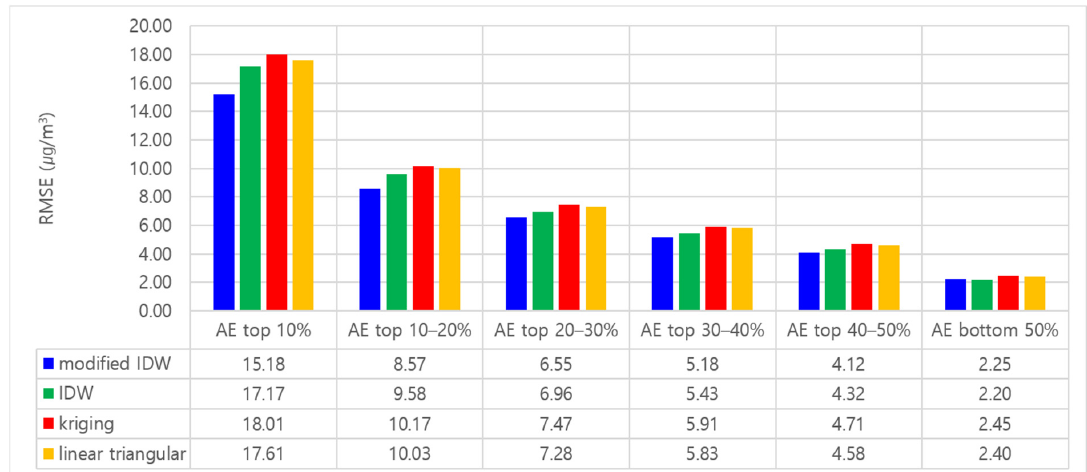
Figure 8. MAPE levels of estimated PM2.5 for different algorithms based on AE levels.